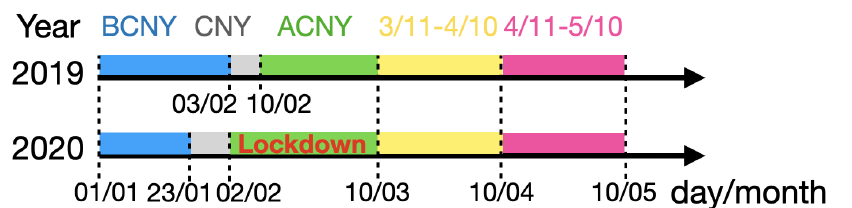
Figure 2. The four periods (before the Chinese New Year (BCNY), after the Chinese New Year (ACNY), 3/11–4/10, and 4/11–5/10) in 2019 and 2020. Note that the Chinese New Year (CNY) national holiday was not considered in this